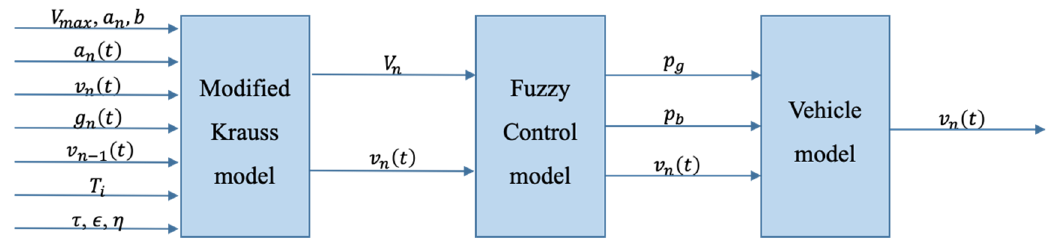
Figure 2. Schematic diagram of the driver model and vehicle model system.